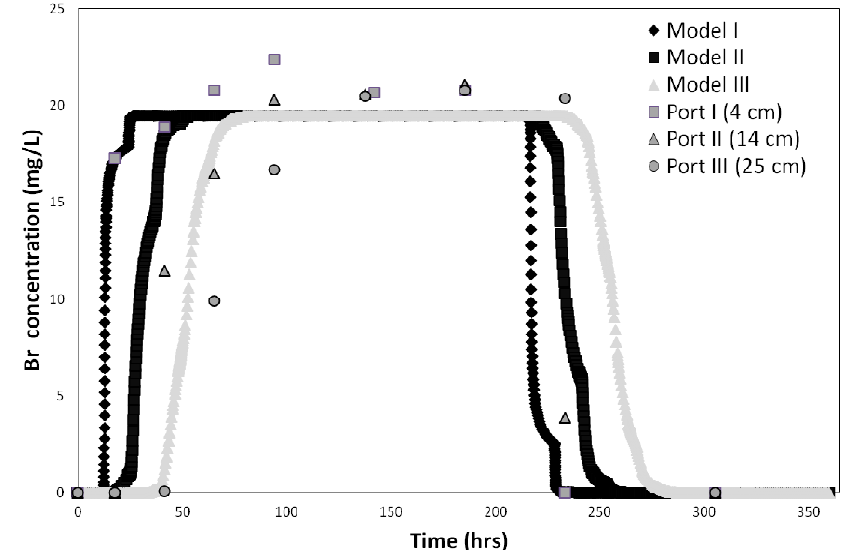
Figure 3. Bromide tracer test results and best fit obtained for the three soil column depth intervals (0–4 cm, 4–14 cm, and 14–25 cm) in sandy soil.